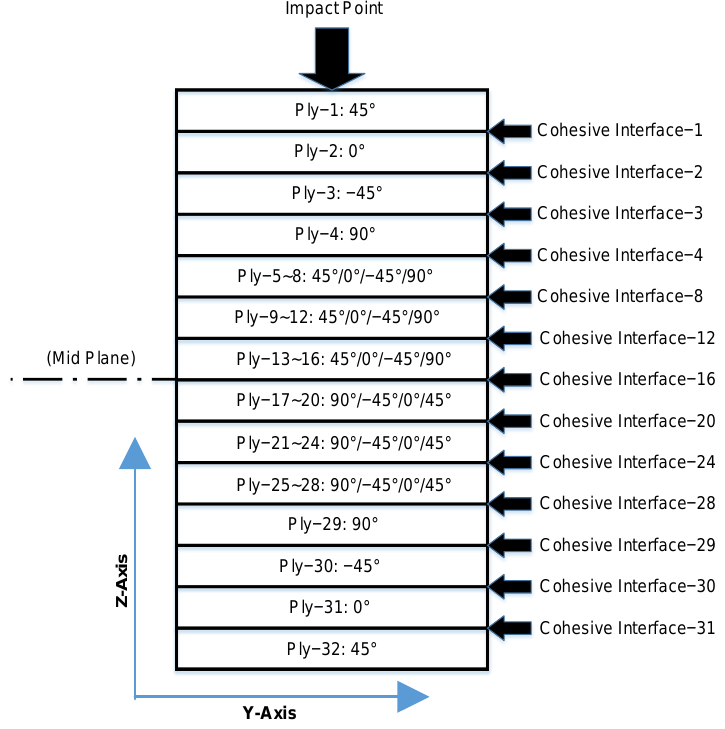
Figure 4. Laminate stacking and cohesive interface sequence diagram.